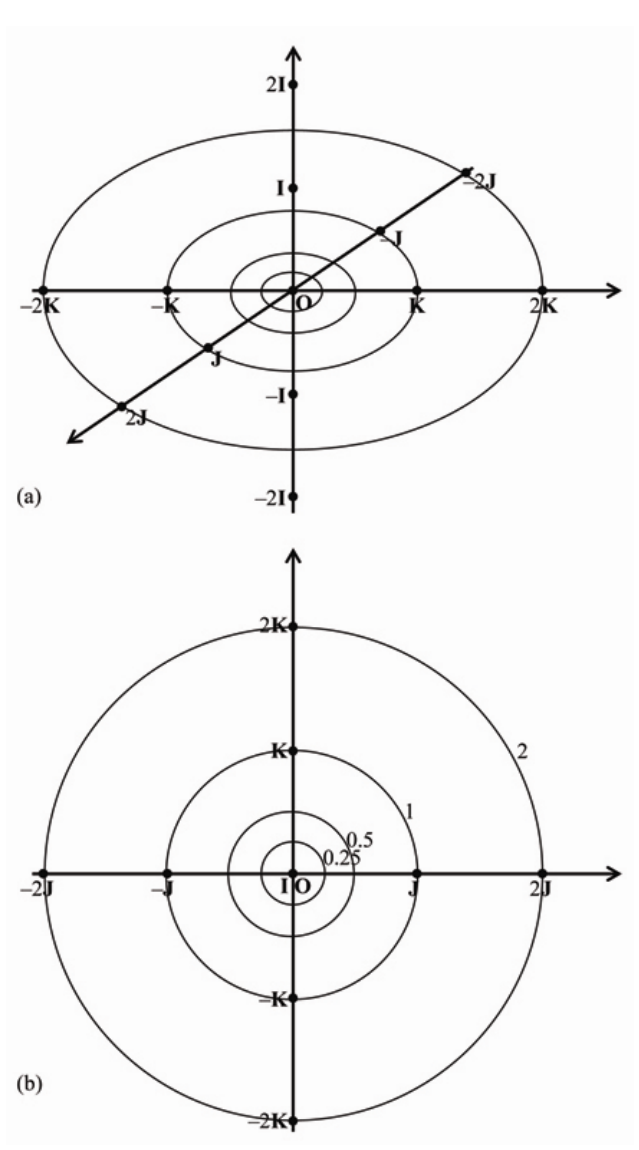
Figure 9 Graphical representation of the abstract space known as symmetric dioptric power space with circles representing the powers of 0.25-D, 0.5-D, 1-D and 2-D Jackson cross-cylinders. The space is tilted in (a) to show the three axes I , J and K . In (b) axis I is orthogonal to the plane of the figure and points towards the reader; J and K span the antistigmatic plane and are in the plane of the figure. The antistigmatic plane represents the powers of all possible Jackson cross-cylinders.